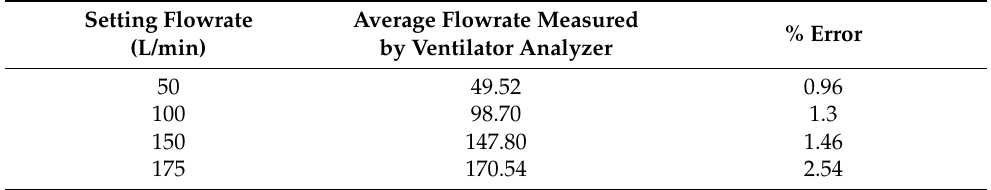
Table 6. Flowrate-accuracy test.